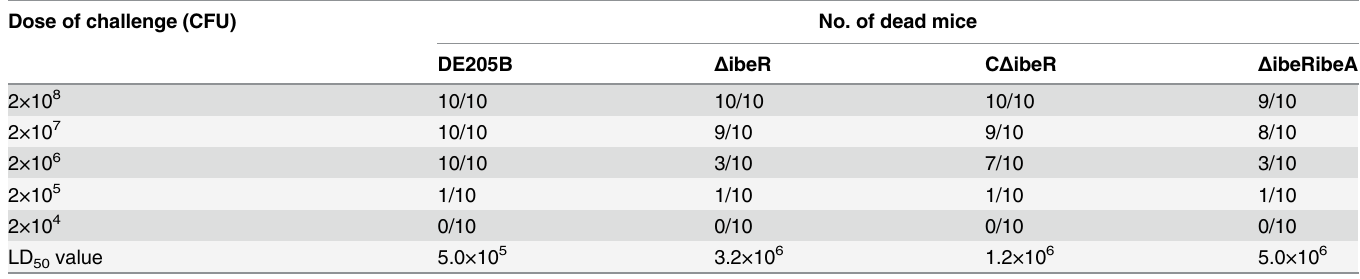
Table 3. Calculations of LD 50 for different